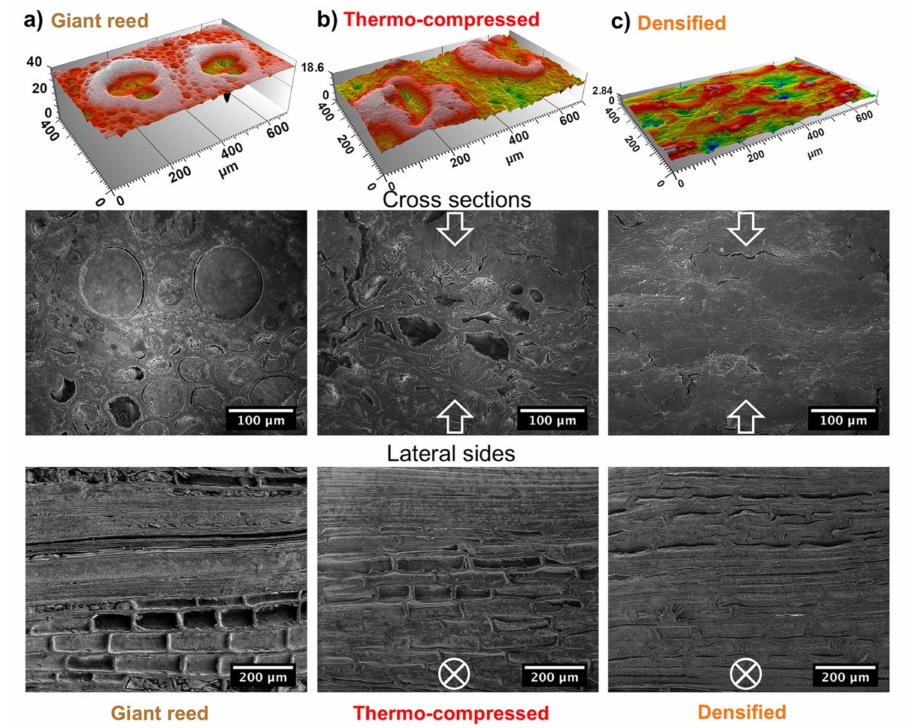
Figure 1. The first row of images shows the cross-section morphologies of ( a ) R, ( b ) TC, ( c ) D samples obtained by profilometry analysis. The second and third rows show SEM images of the cross sections and the lateral sides of ( a ) R, ( b ) TC, ( c ) D. White arrows in SEM images show the direction of applied pressure in the thermo-compression